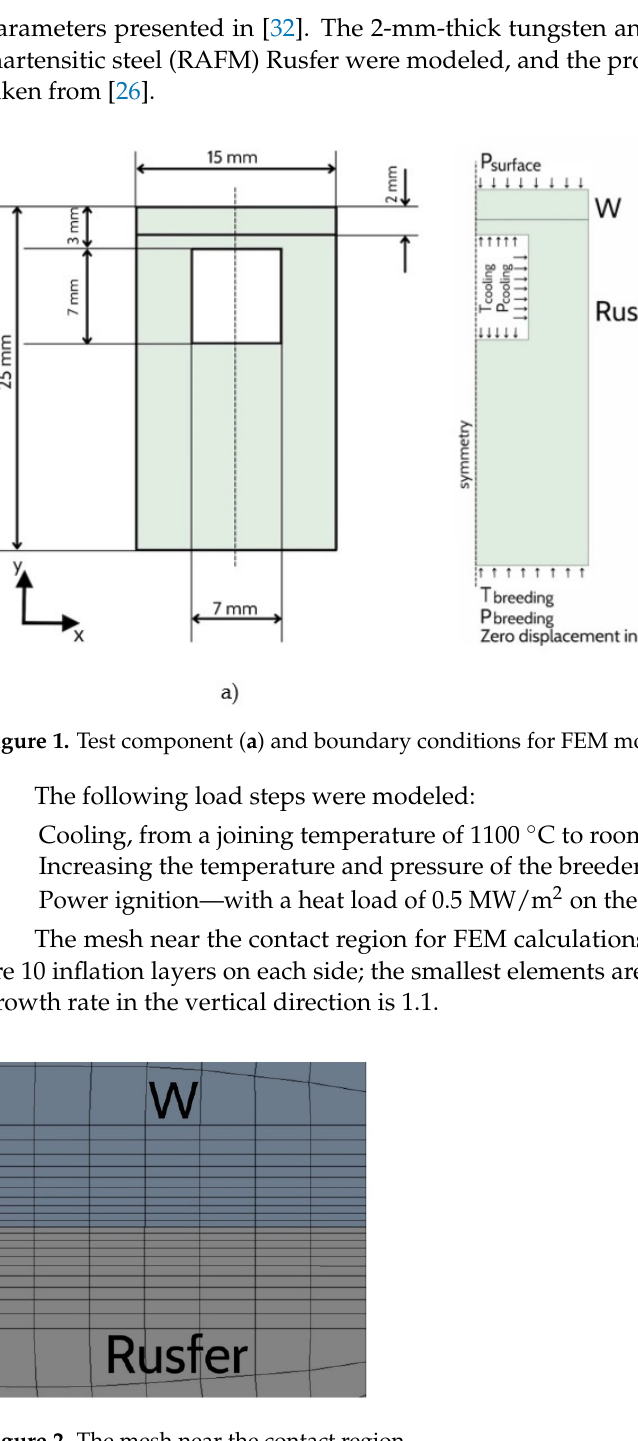
Figure 2. The mesh near the contact region.